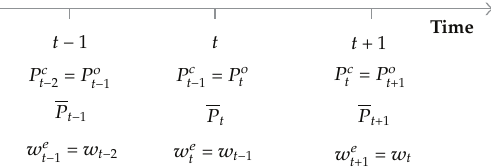
Figure 1: Frame of the discrete